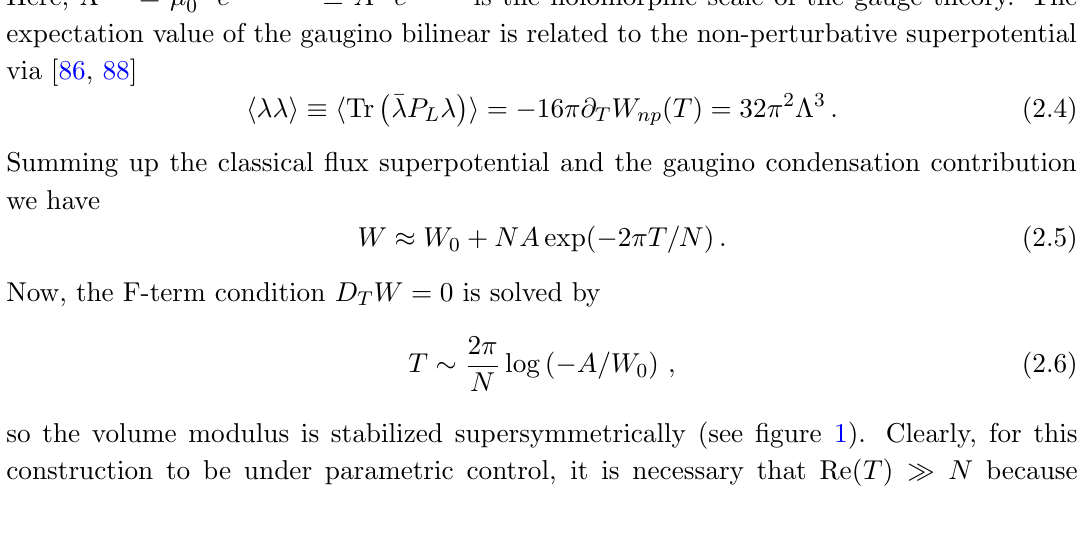
Figure 1 . In blue: the supersymmetric KKLT potential for parameters NA = 1, 2 (cid:25) W 0 = (cid:0) 10 (cid:0) 4 . In red: the uplifted potential with appropriately (cid:12)ne tuned warp factor a 2 There is a dS minimum at t (cid:17) Re( T ) (cid:25) 110. The maximal possible uplift occurs with